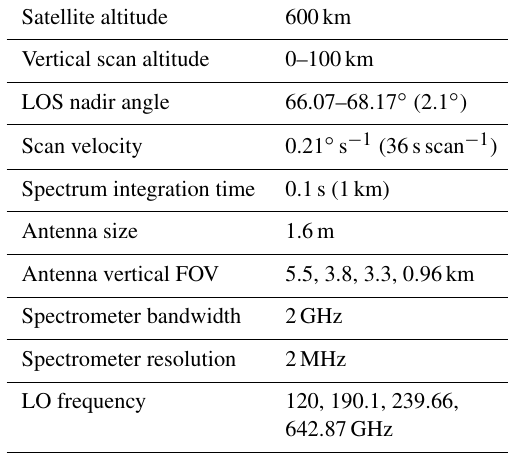
Table 1. Characteristics of the TALIS